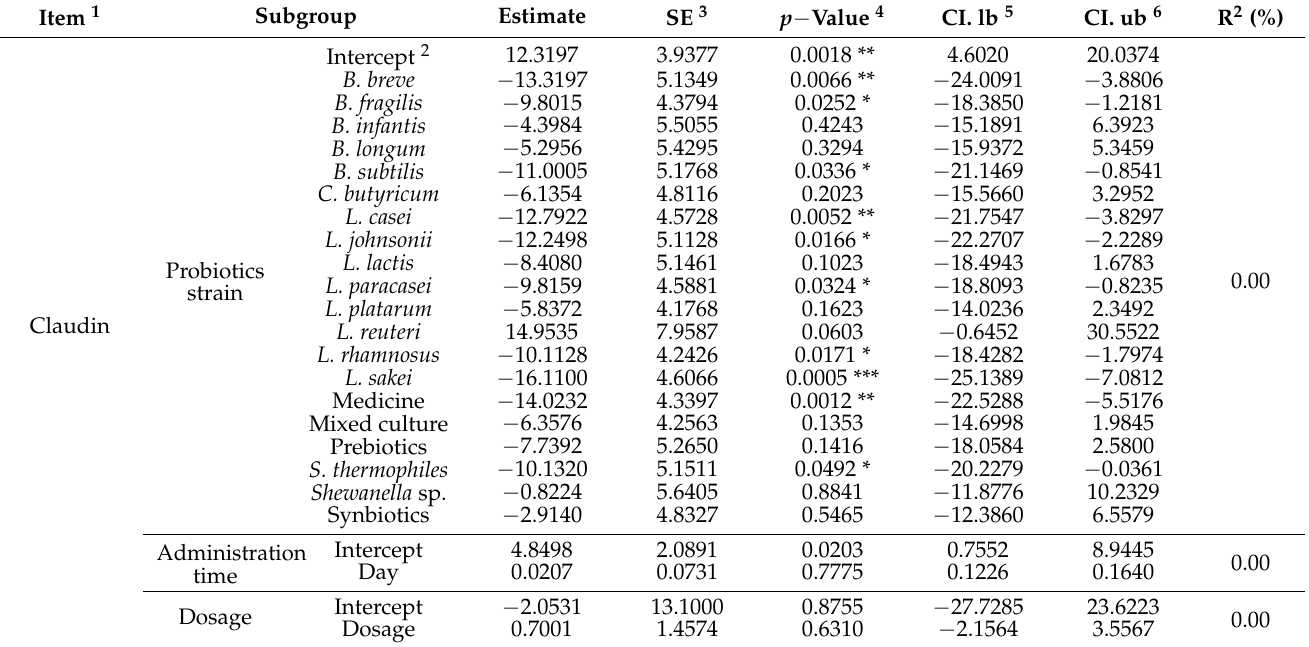
Table 4. Meta-regression to analyze the effect of probiotics strain, administration time, and dosage on the expression of the tight junction